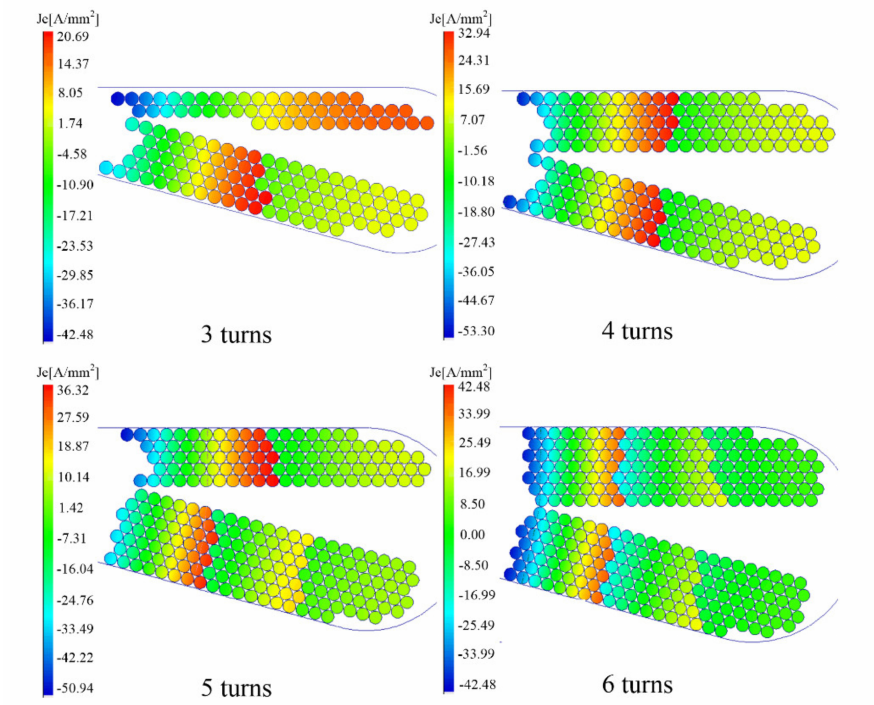
Figure 15. Current density with conductor turns at 1000